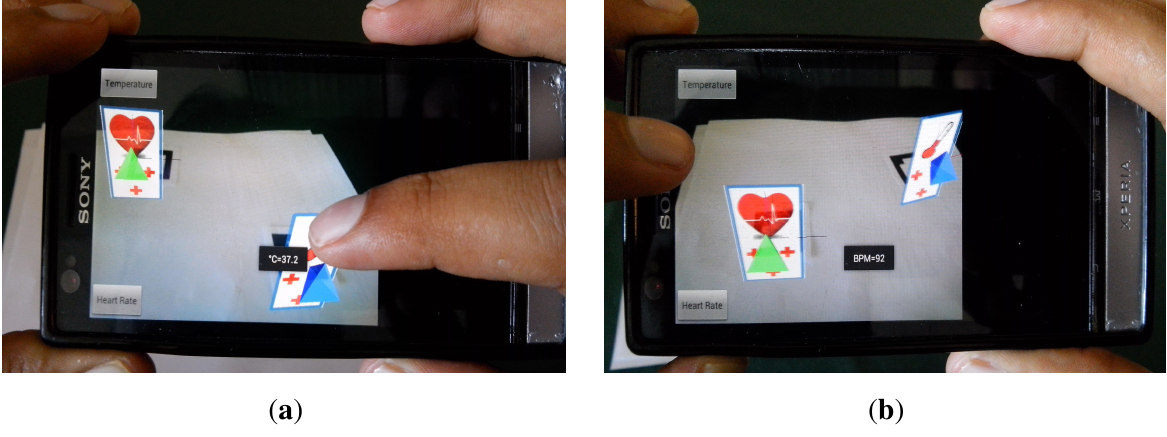
Figure 12. Example of VPF application: ( a ) VPF shows current BT value, and ( b ) VPF shows current HR